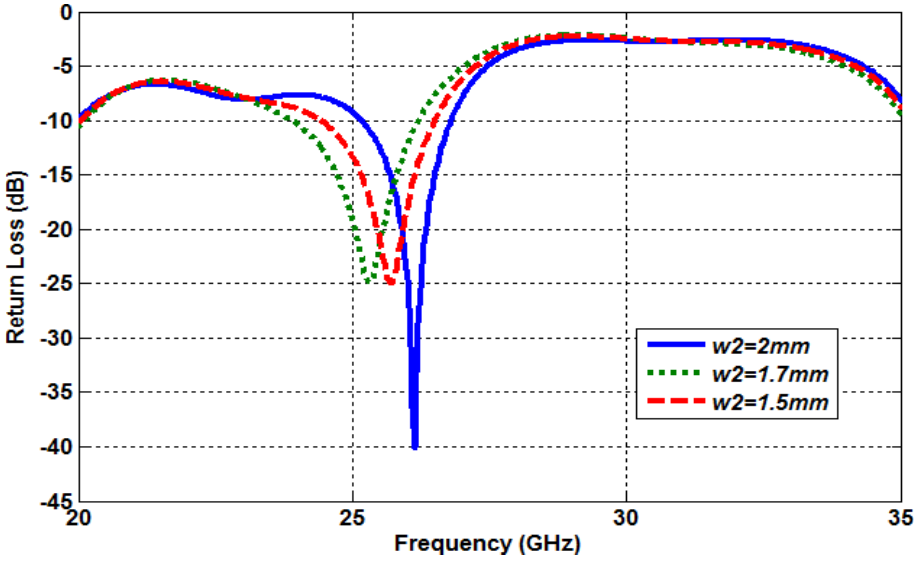
Figure 3. Antenna performance with the variations in term w2.